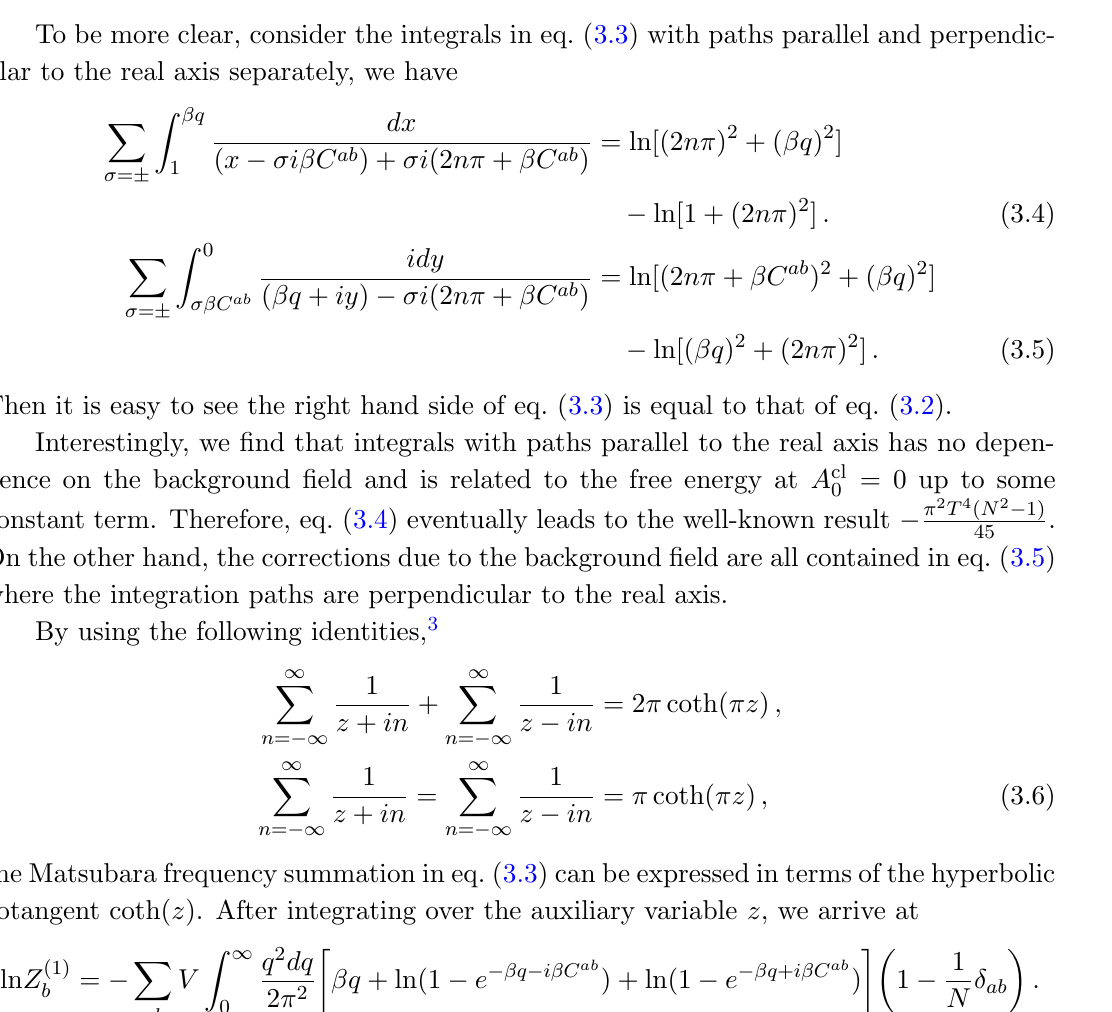
Figure 3 . Integration paths for the bosonic